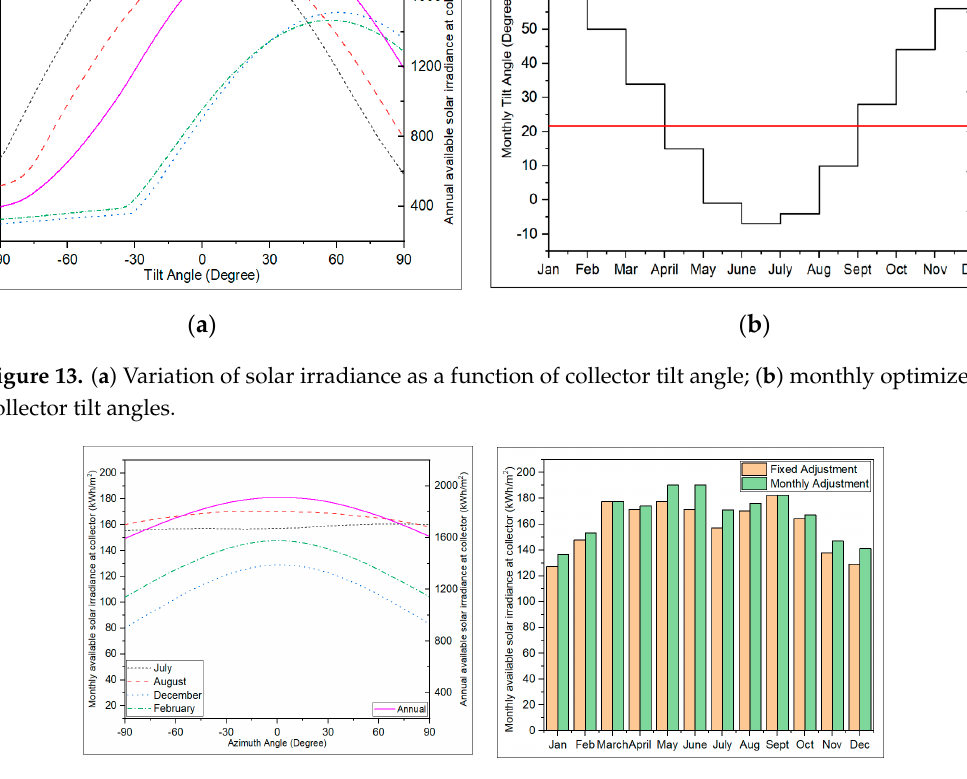
Figure 14. ( a ) Variation of solar irradiance as a function of collector orientation; ( b ) solar irradiance available at collector surface with fixed and monthly adjustment.